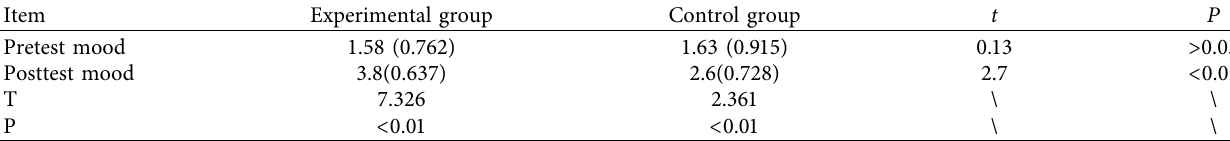
Table 1: Comparison of emotion between the two groups before and after the test.